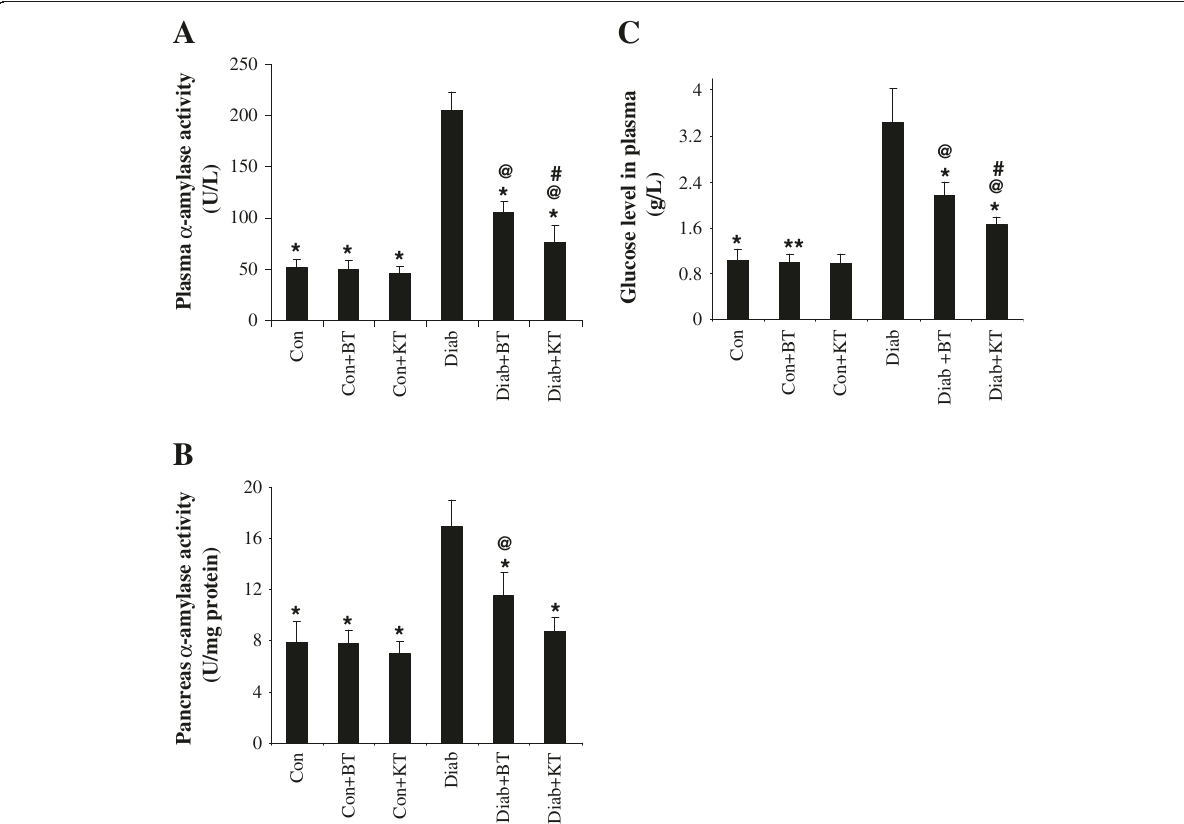
Figure 2 Effect of KT and BT on α -amylase activity in plasma (A), pancreas (B), and blood glucose levels (C) of surviving diabetic rats. Data represent mean±S.D (n=8 for each group). The values are statistically significant and presented as follows: single asterisk (*), p < 0.05 vs. control diabetic rats (Diab); commercial at (@), p < 0.05 vs. respective control rats (Con) [i.e. on the same corresponding tea treatment]; number sign (#), p < 0.05 vs. diabetic rats treated with BT